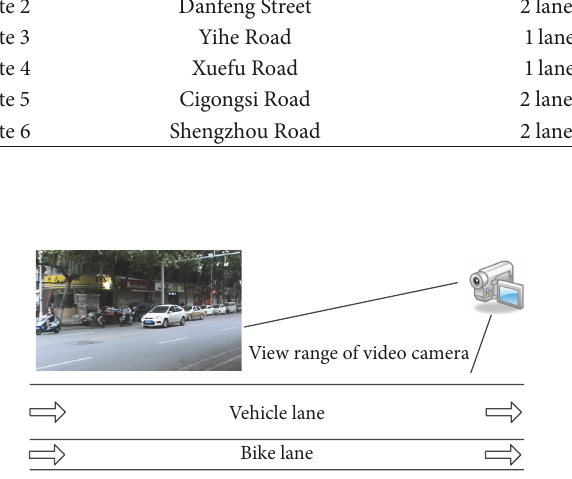
Figure 2: Data collection with video